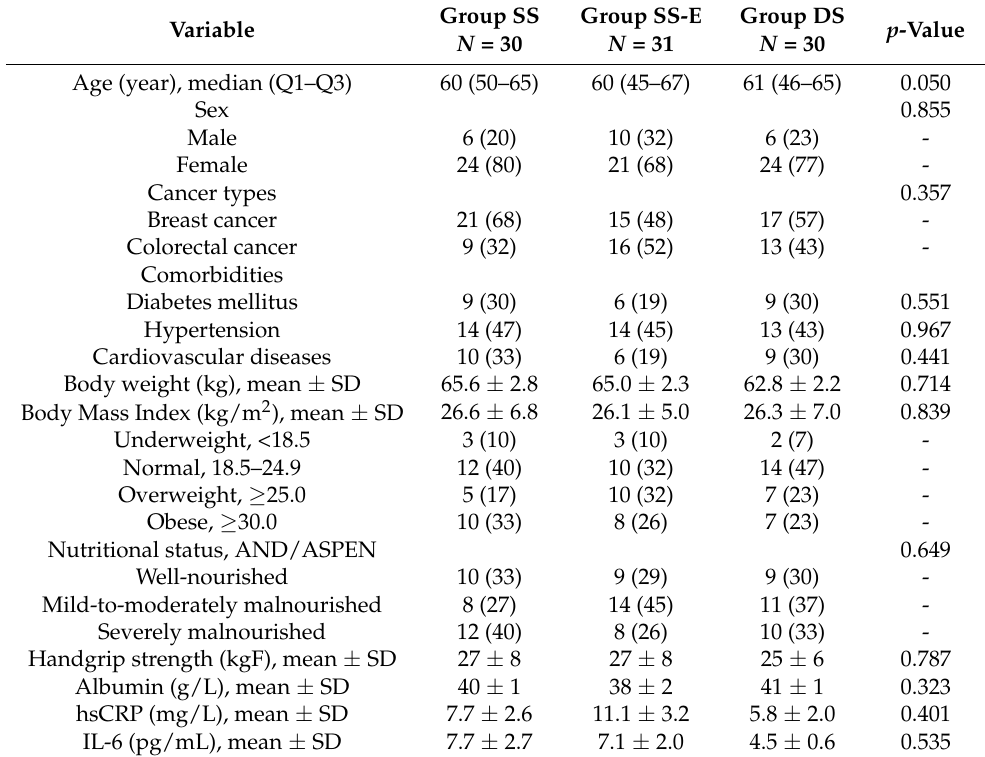
Table 1. Baseline characteristics of